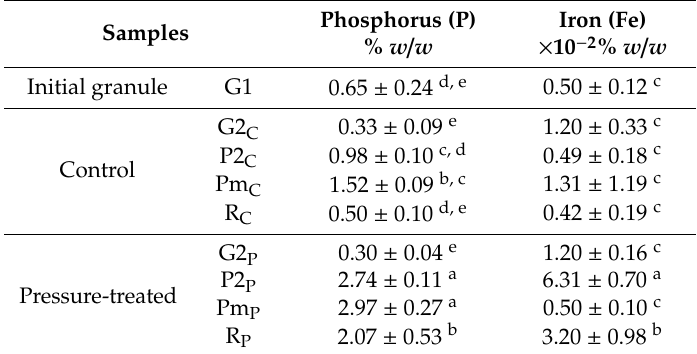
Table 2. Phosphorus and iron contents of control and pressure-treated fractions of egg